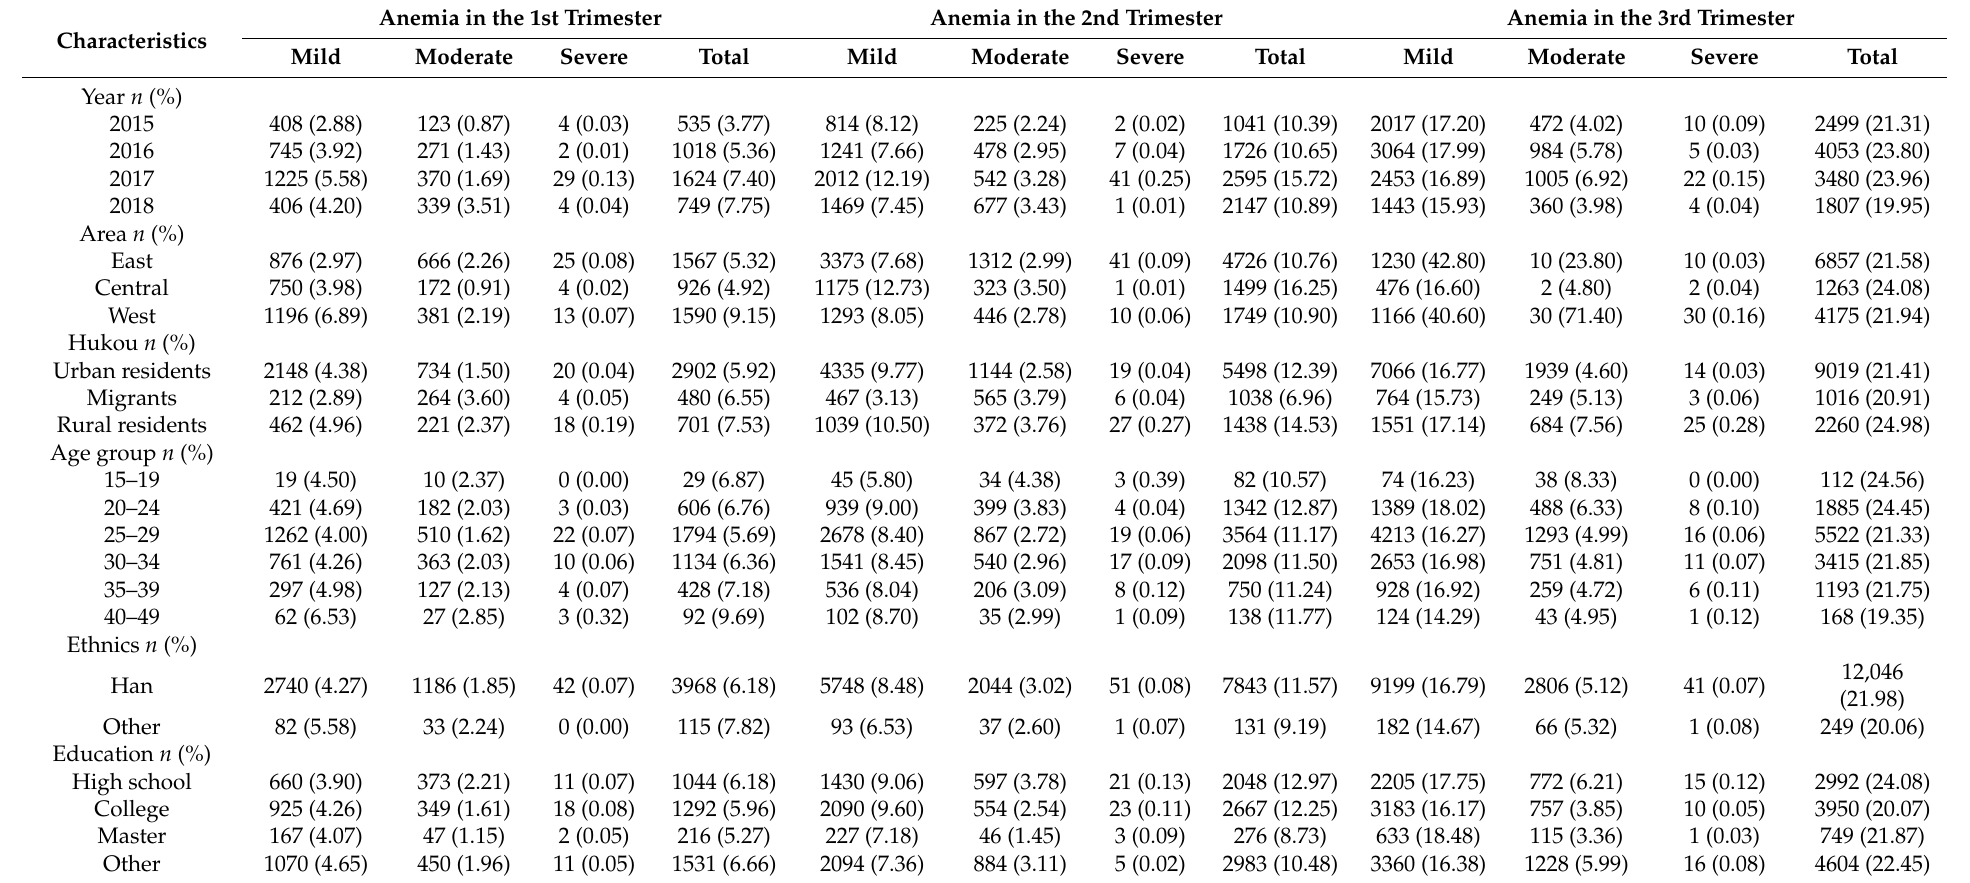
Table 5. The prevalence of anemia (%) in subgroups according to